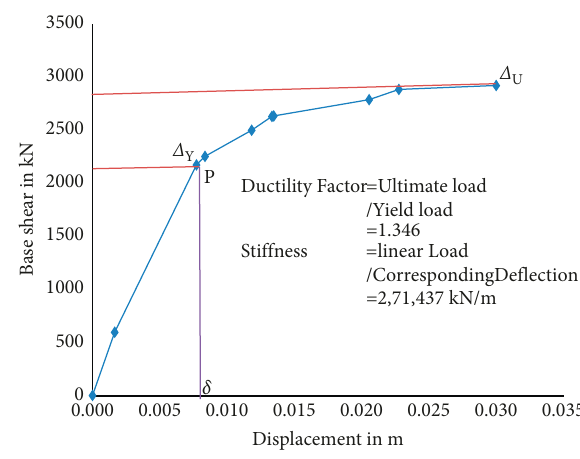
Figure 5: Bare frame in the Y direction.